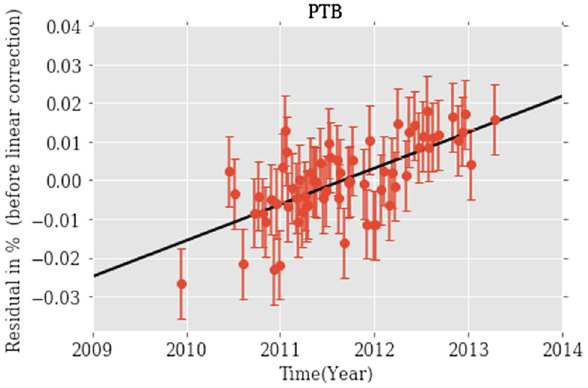
Fig. 1 The original PTB dataset [7] showing the 36 Cl decays. The best-fit line has a slope equal to 9 . 36 × 10 − 5 and y -intercept is equal to 0.81